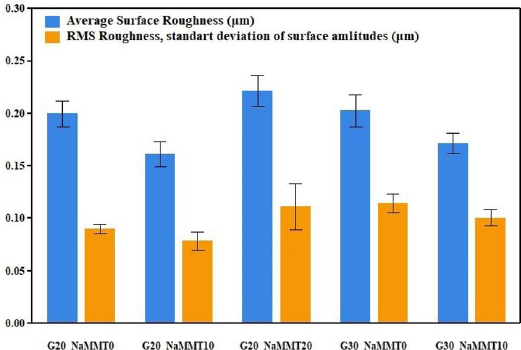
Figure 7. Histogram of average surface roughness and RMS roughness for representative conventional composite and nanocomposite starch- based films with different glycerol and clay